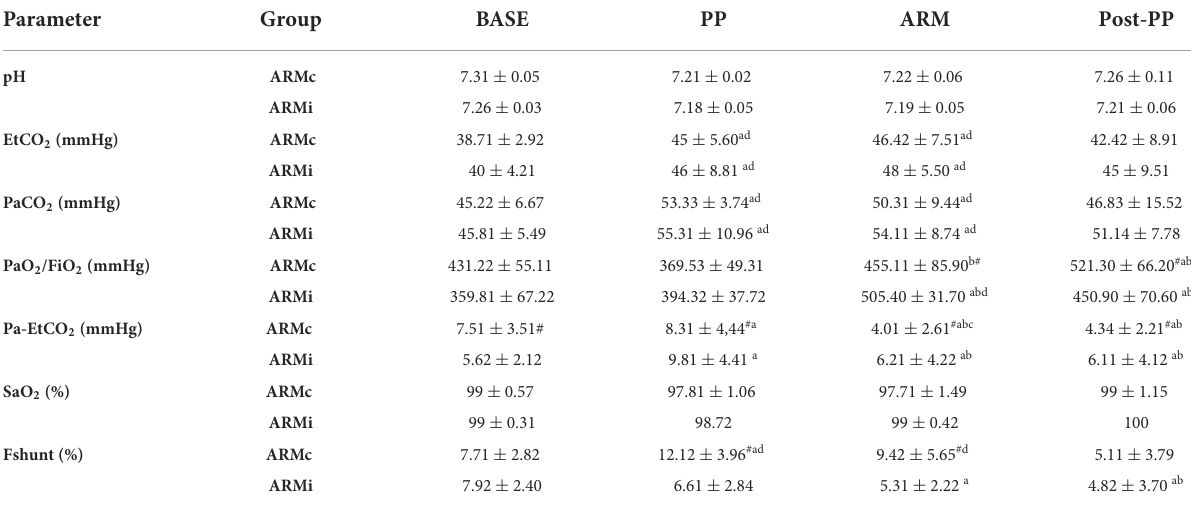
TABLE 2 Mean ± SD of the gas exchange parameters evaluated in 20 dogs mechanically ventilated, undergoing laparoscopic surgery. Parameter Group BASE PP ARM